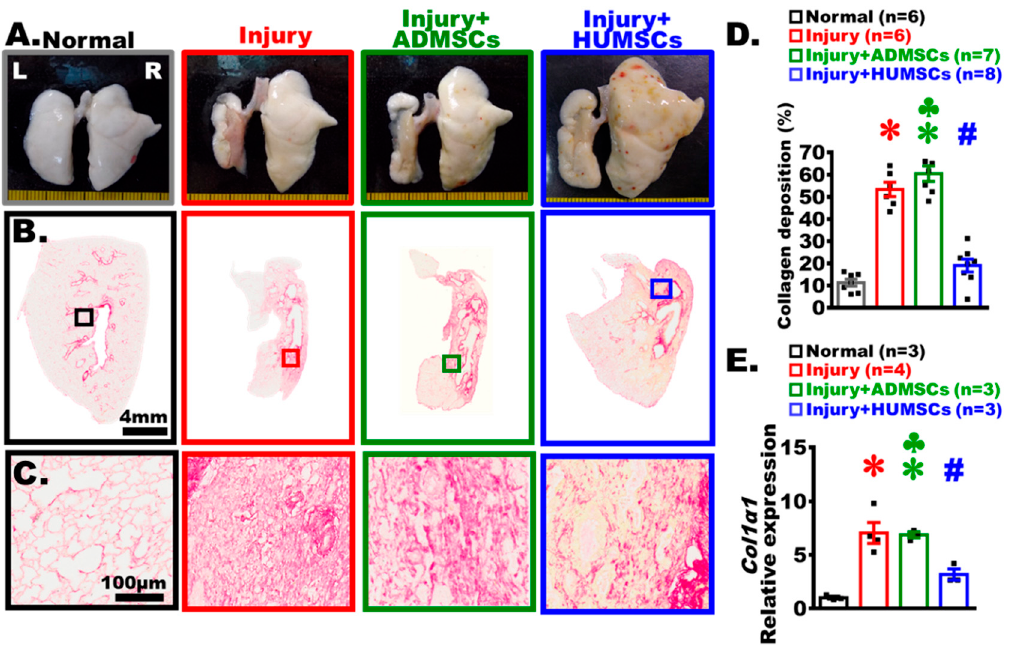
Figure 4. Transplantation of HUMSCs, but not ADMSCs, reduced collagen accumulation in PF rats. Photographs of the lungs’ anterior views were acquired from each group on Day 49. The left lungs clearly shrank, and alveoli were only seen in the peripheral region of the left lung, with the exception of the Injury+HUMSCs group ( A ). Lower-magni fi cation ( B ) and higher-magni fi cation ( C ) photo- graphs of Sirius-red-stained left lung sections from each group were acquired on Day 49 to highlight the presence of collagen. Quanti fi cation of the percentage of area occupied by collagen in the rats’ left lung revealed that HUMSCs transplantation alleviated the fi brosis in rats with PF, in comparison with those in the Injury and the Injury+ADMSCs groups ( D ). On Day 49, rat Col1a1 mRNA was collected from the left lung and examined with qRT-PCR. The Col1a1 expression in the Injury+HUM- SCs group was signi fi cantly lower than those in the Injury and Injury+ADMSCs groups. The fi gure shows the number of rat samples in each group (D and E ). ✽ : p < 0.05 (vs. the Normal group); #: p < 0.05 (vs. the Injury group); ♣ : p < 0.05 (the In- jury+ADMSCs group vs. the Injury+HUMSCs